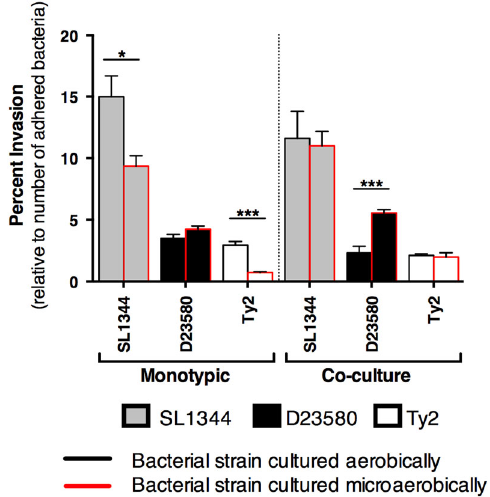
Fig. 4 Microaerobic culture enhances the invasiveness of adherent D23580 in the 3-D co-culture model. SL1344 ( gray bars ), D23580 ( black bars ) and Ty2 ( white bars ) were cultured under either aerobic conditions ( black border ) or microaerobic conditions ( red border ) and used to infect the 3-D epithelial or 3-D co-culture model. All data for each strain were normalized to the number of bacteria that adhered. Statistically signi fi cant differences for each strain between oxygen conditions are indicated as (*) p < 0.05 or (***) p < 0.001. Error bars represent standard deviation from two biological replicates, each conducted in technical triplicate